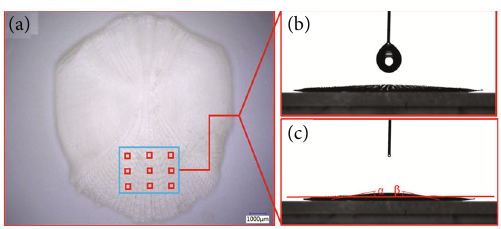
Figure 24: Image of fi sh scale surface contact angle